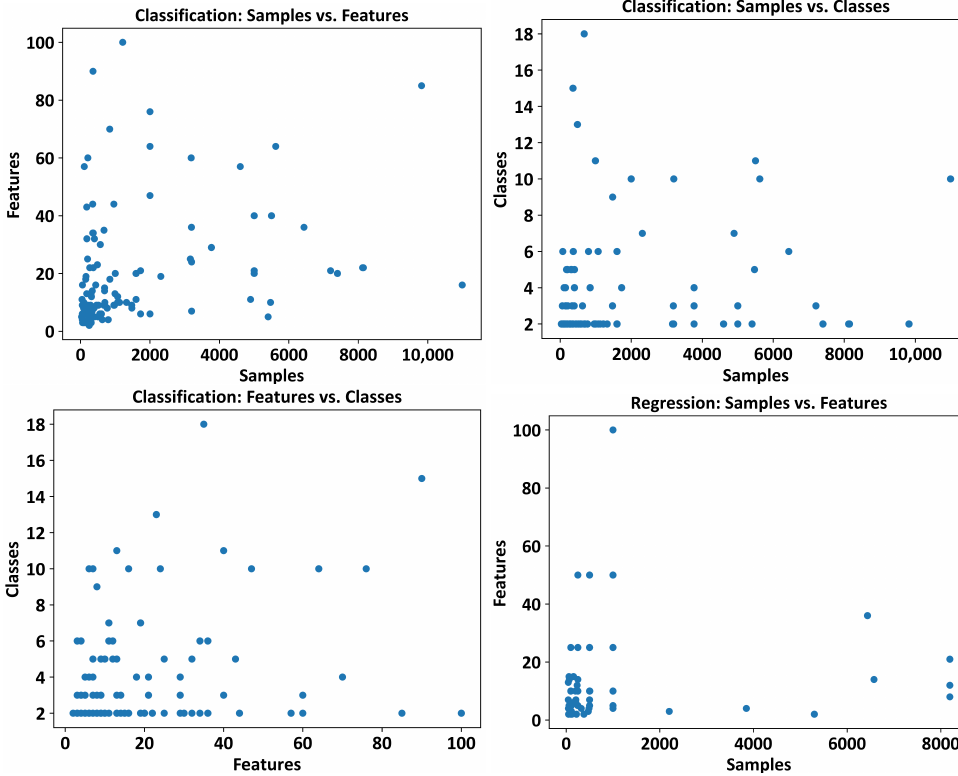
Figure 1. Characteristics of the 144 classification datasets and 106 regression datasets used in our